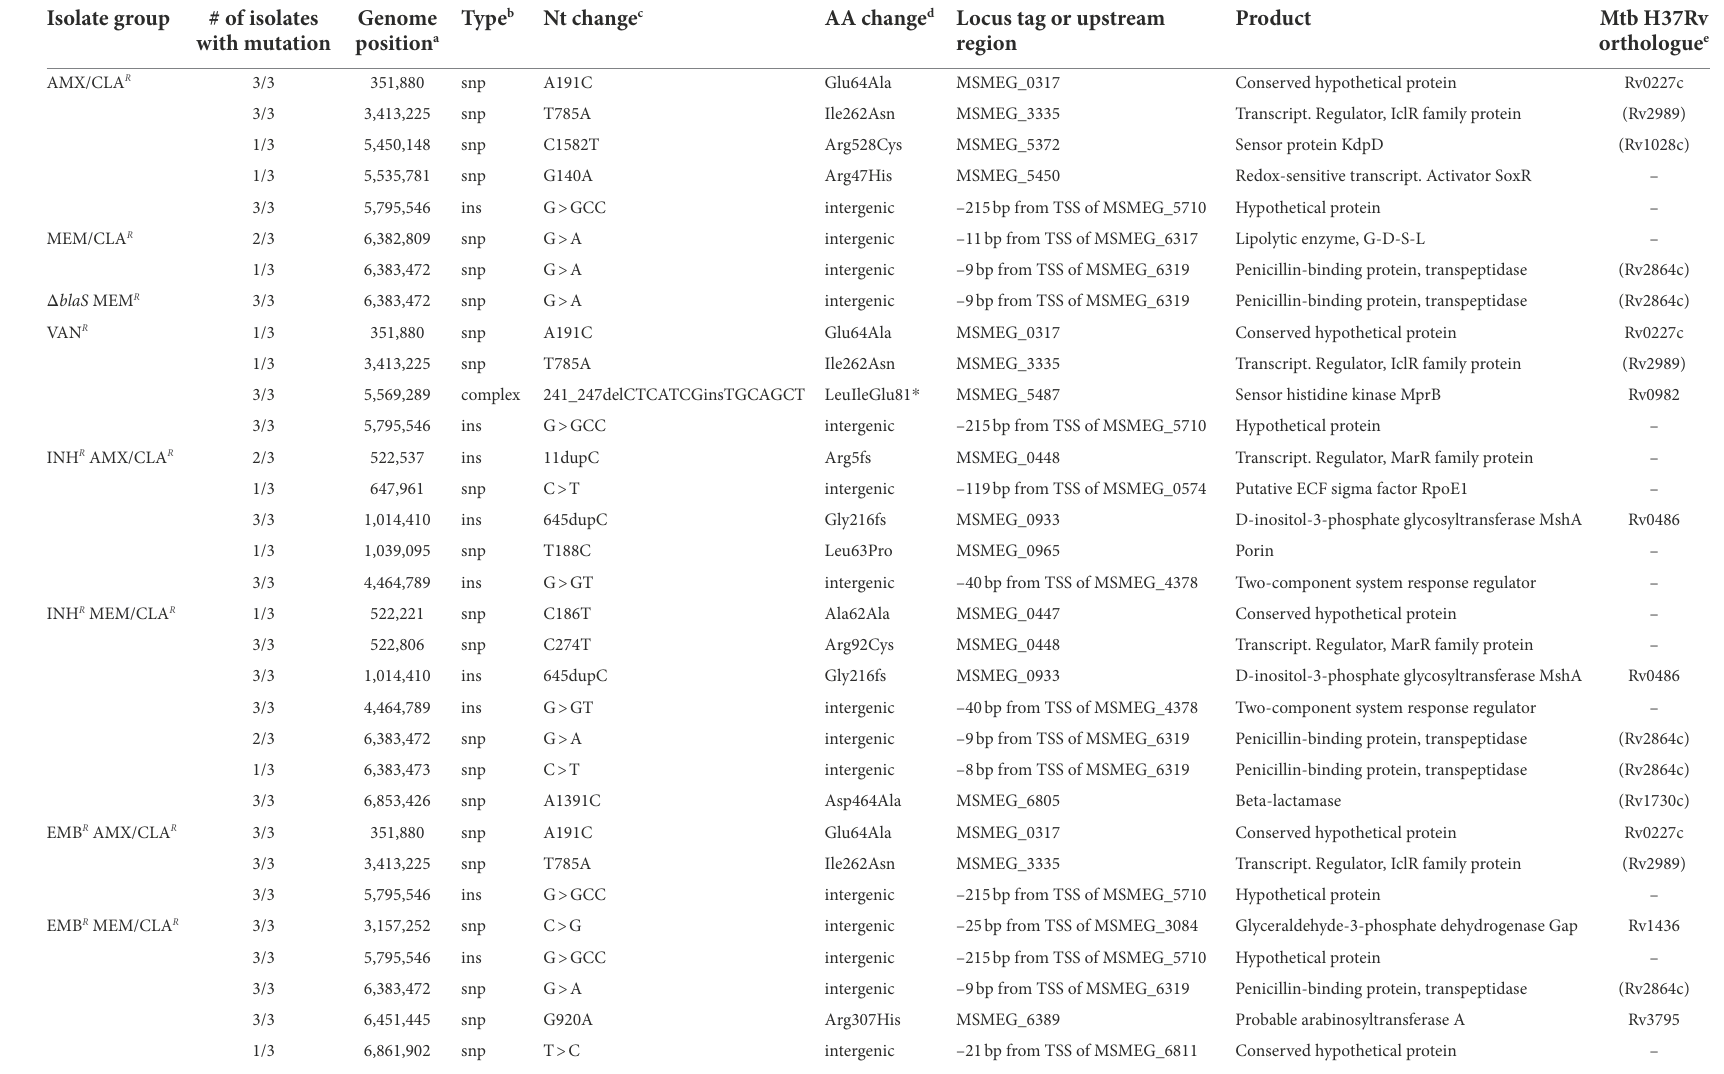
TABLE 3 Mutations and affected genes identified on Msm isolates selected with beta-lactams or vancomycin. Isolate